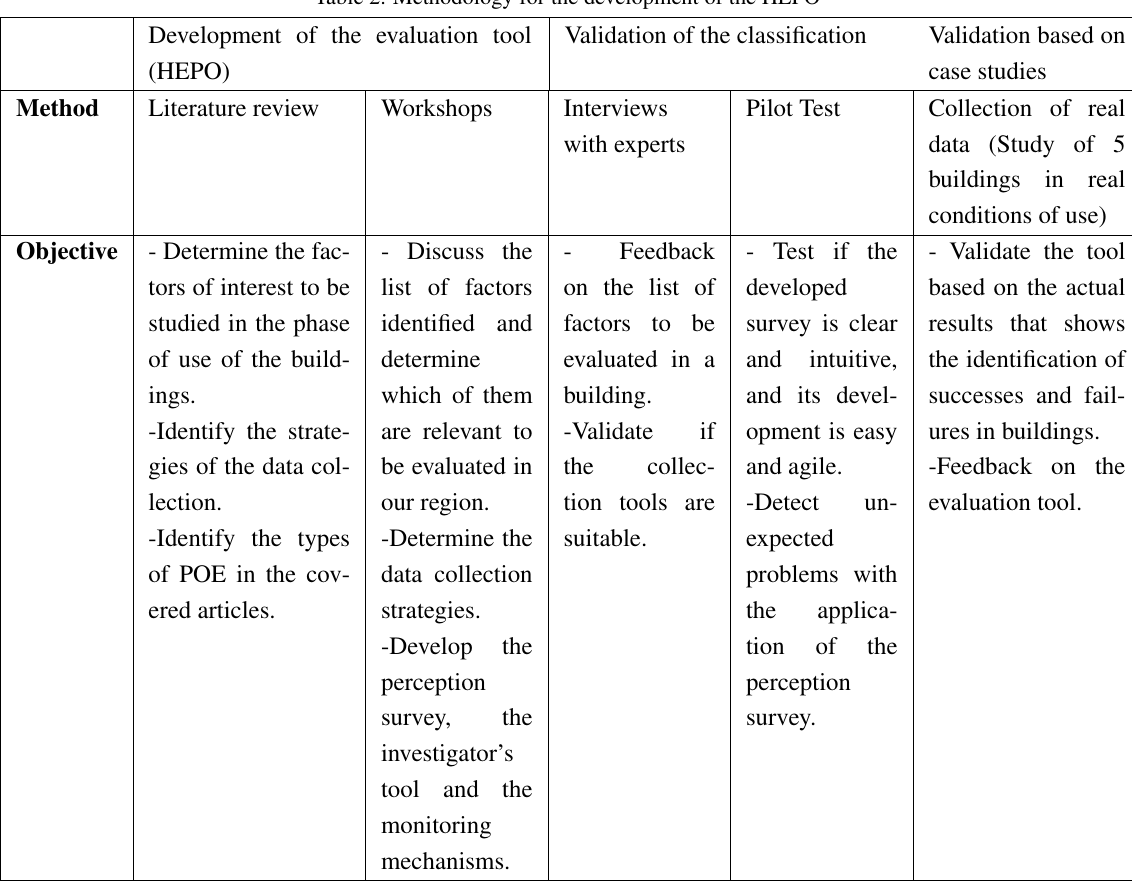
Table 2. Methodology for the development of the